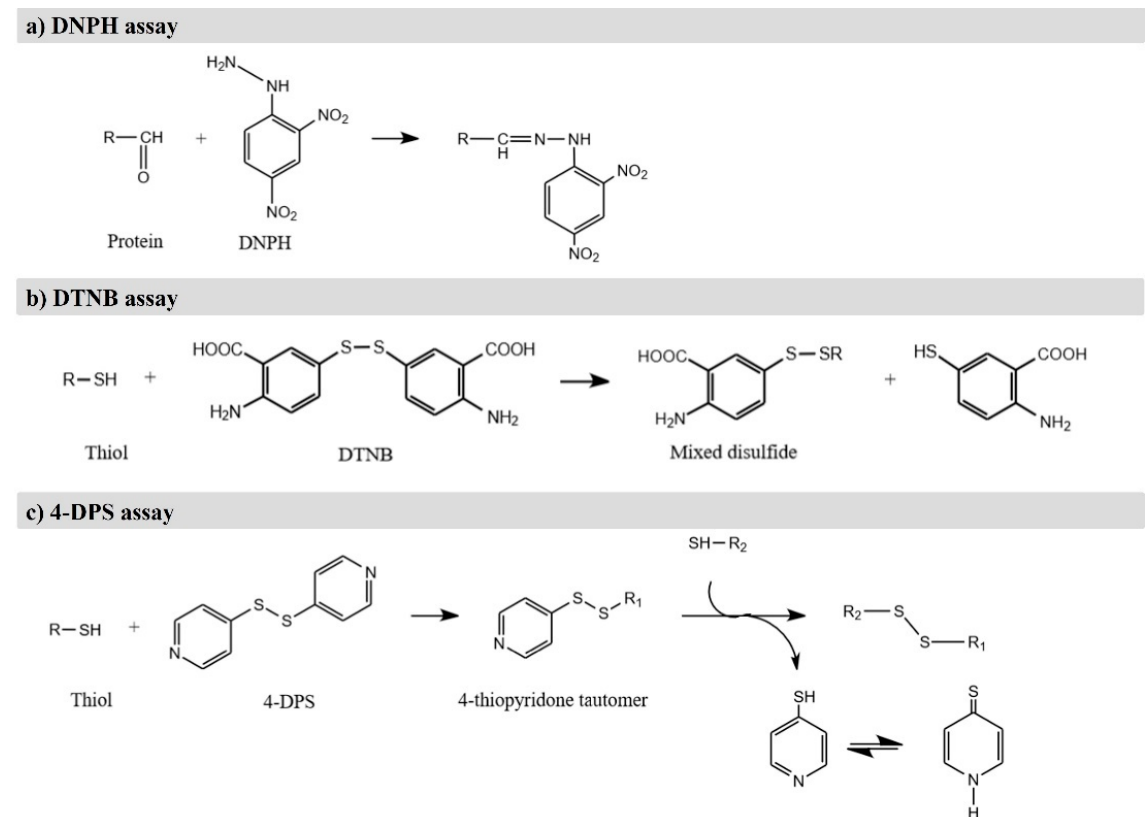
Figure 4. ( a ) Derivatization of carbonyl group with DNPH; ( b ) Derivatization of thiol group with DTNB; ( c ) Derivatization of thiol group with 4-DPS.